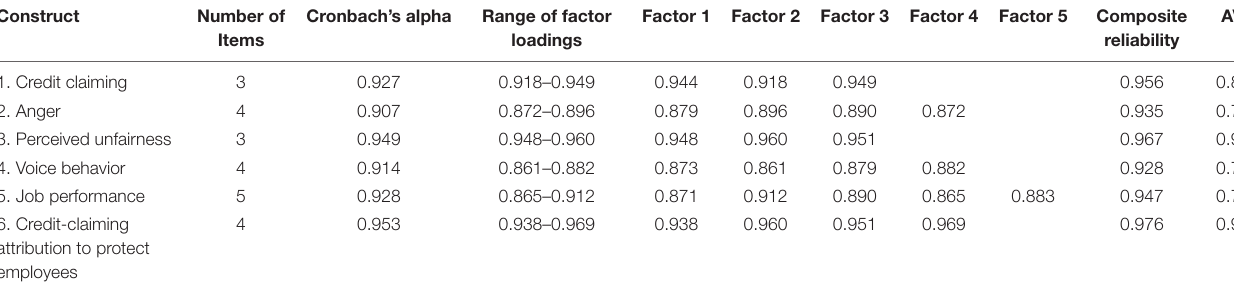
TABLE 2 | Cronbach’s alpha, factor loadings, composite reliability, and AVE values. Construct